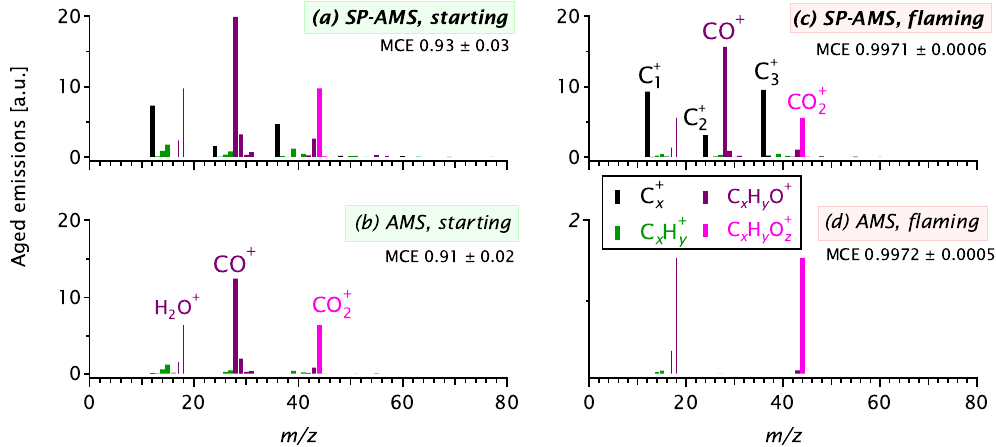
Figure 4. Aged-emissions SP-AMS and AMS mass spectra for the starting-phase (highest OM emissions) and flaming-phase (lowest OM emissions, high BC emissions) beech-combustion experiments, in analogy to Fig. 3. Note the change of scale in panel (d) . The estimated signals at O + , OH + , and H 2 O + have been estimated from CO + (Sect. 2.3) and therefore plotted with thinner bars. In panel (d) , no CO + 2 signal is shown as that species was below its detection limit (2.4